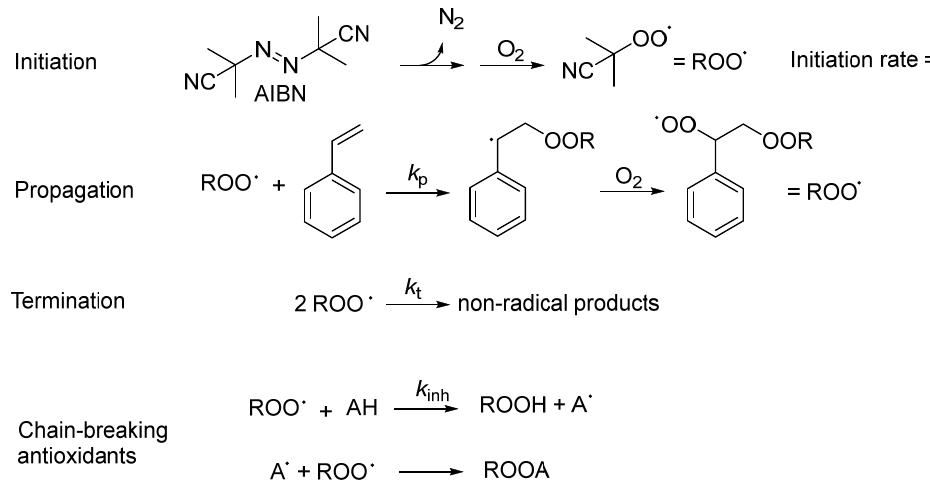
Scheme 2. Reaction scheme of styrene autoxidation inhibited by a chain-breaking antioxidant